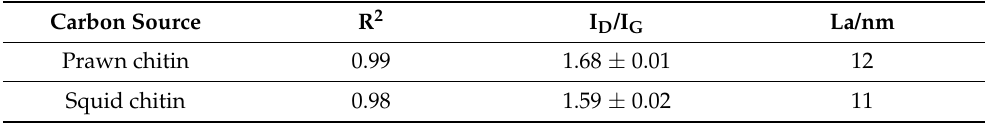
Figure 6. Raman spectra of the chitin-based carbons. Table 2. I D /I G and crystallite size values of the prawn and squid chitin-based carbons through the peak deconvolution of the Raman spectra in the first Raman